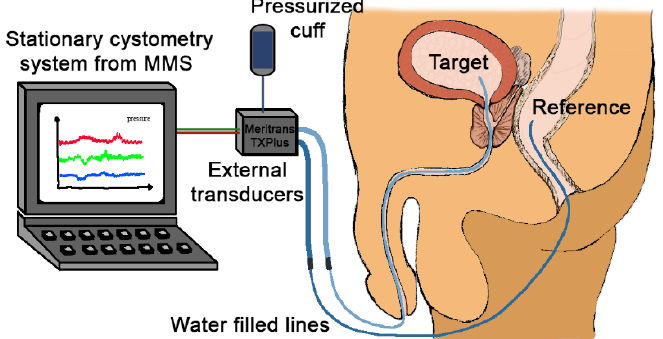
Figure 1. The illustration of the conventional cystometric examination. The setup illustrated here is used for the experimental set ‐ up on the artificial bladder presented in this paper.